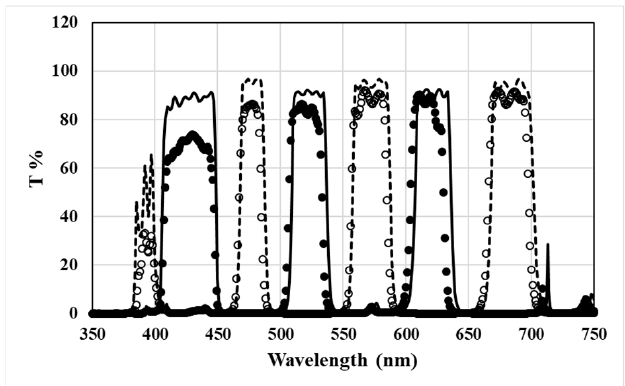
Figure 9. The n and k values for TiO 2 ( a ) and SiO 2 ( b ) used to produce 3D glasses filters, solid line: n ; dash line: k .